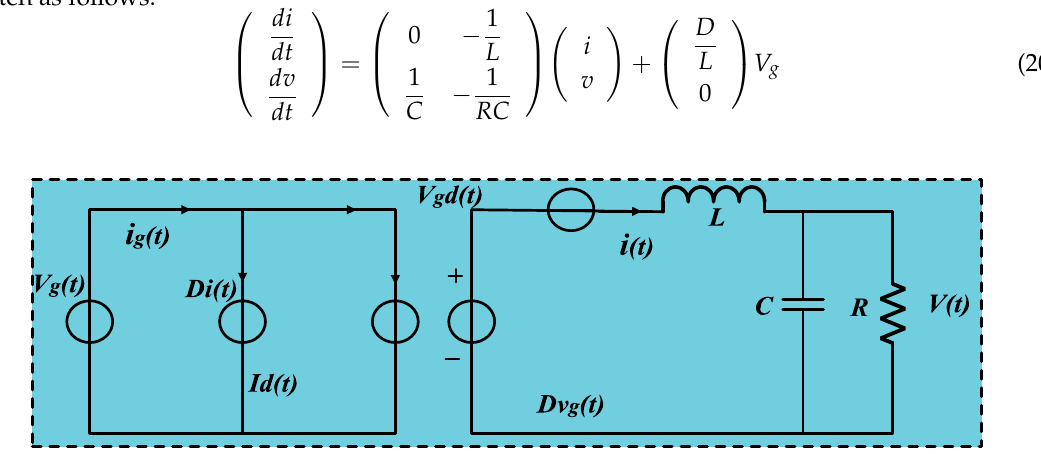
Figure 5. Small signal model of buck converter.